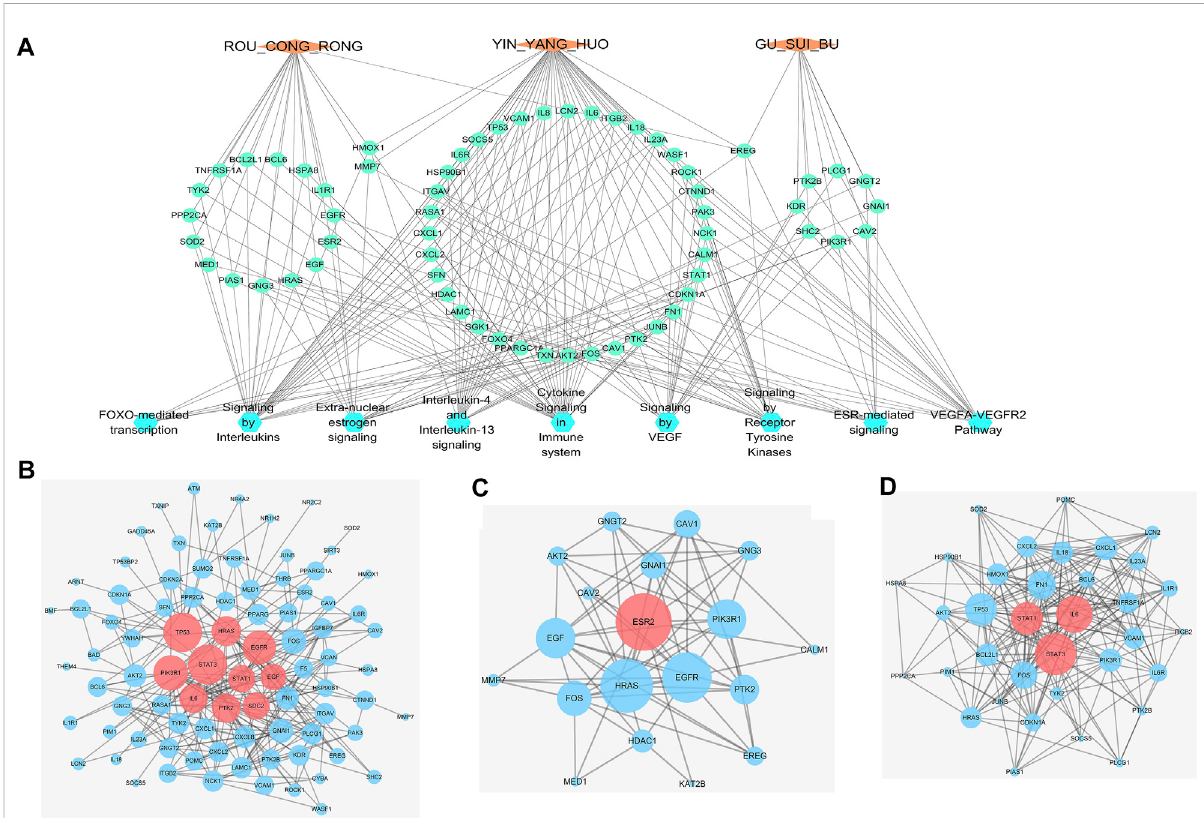
FIGURE 5 Interactive networks of WSYR based on DEGs (A) “ Herbs-DEGs-Pathways ” network. Orange diamond: TCM; green circle: gene; blue circle: pathway (B) Protein — protein interaction network (PPIN) of all DEGs from transcriptome sequencing. Dark pink circle: key targets; blue circle: other targets (C) Hormone-related PPIN based on DEGs.Dark pink circle: key targets; blue circle: other targets (D) In fl ammatory immune-regulated PPIN based on DEGs.Dark pink circle: key targets; blue circle: other